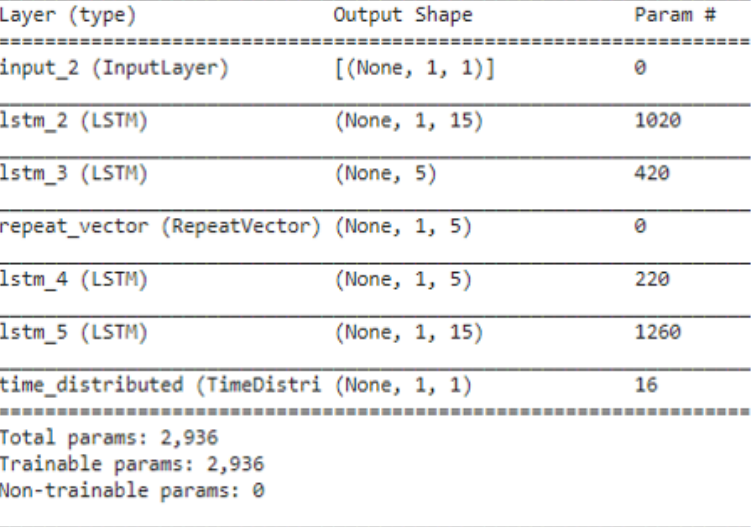
Figure 6. The AE-LSTM model.